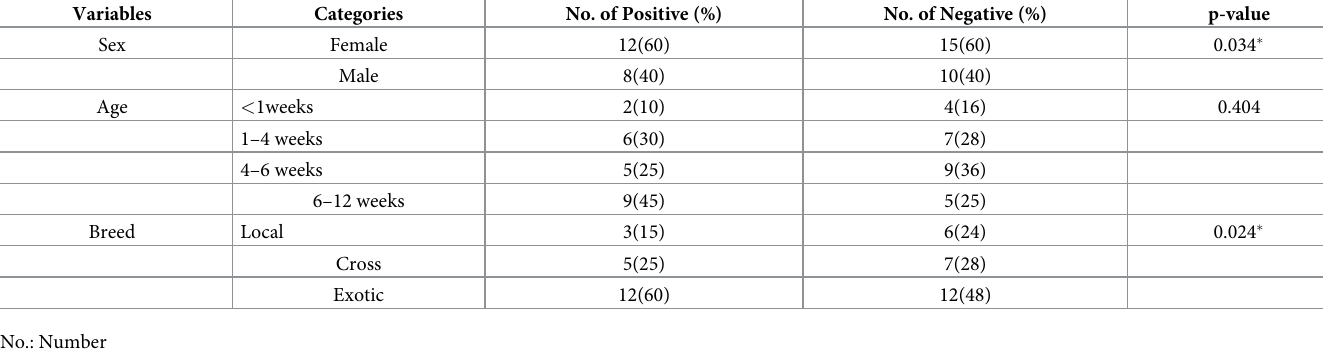
Table 2. Occurrence of E . coli based on age, sex, and breed of diarrheic calves. Variables